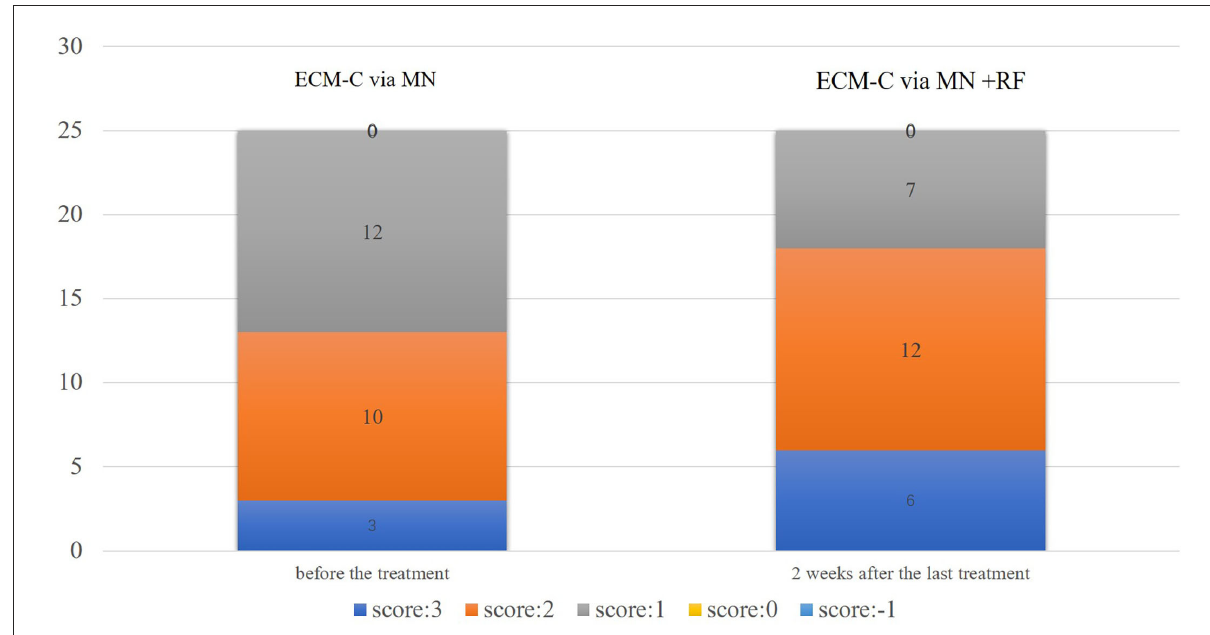
FIGURE8 GAIS assessment graph presentation by participants. GAIS, Global Aesthetic Improvement Scale; − 1 = worse than the baseline, 0 = no change, 1 = improved, 2 = much improved, 3 = very much